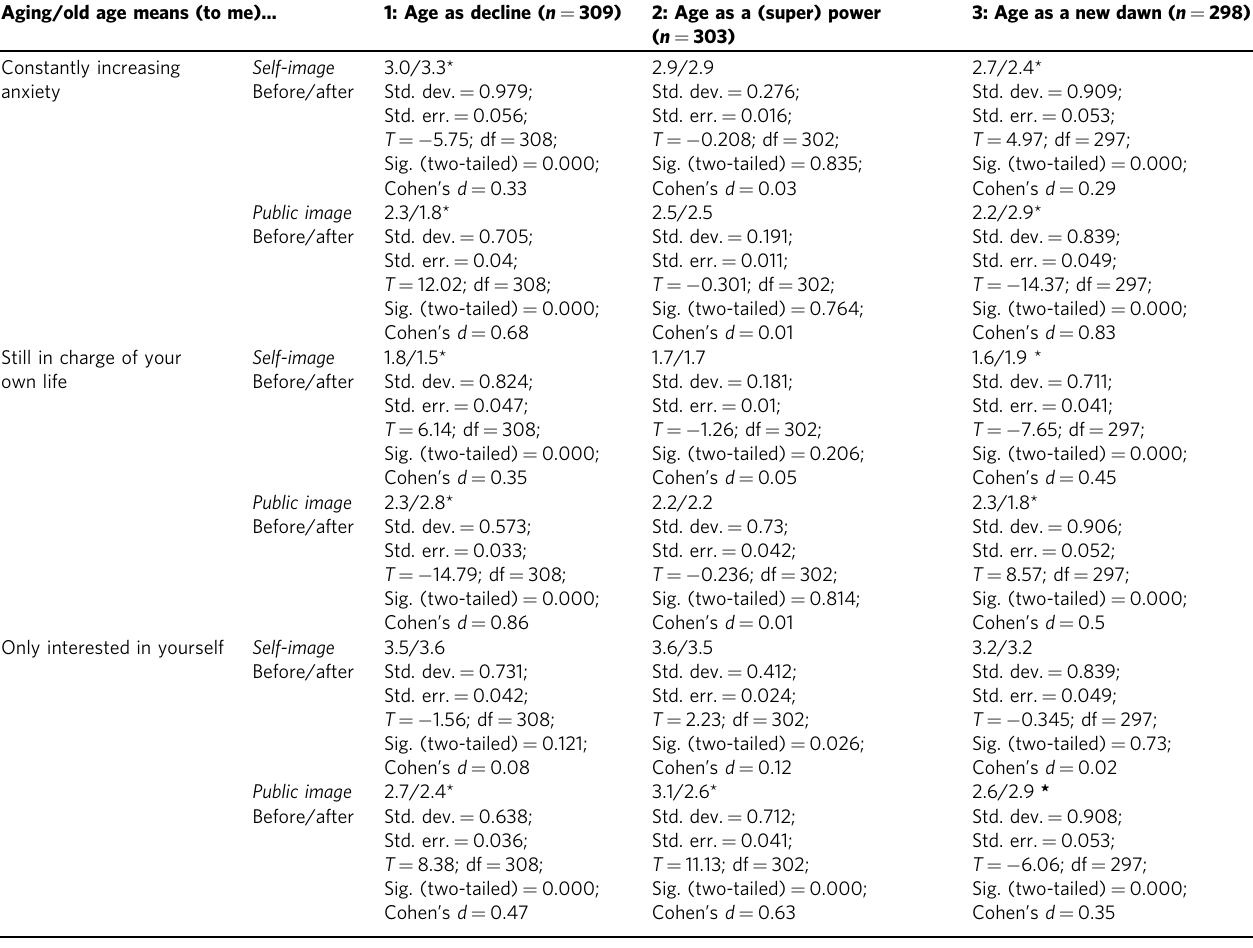
Table 3 Public and self-image of old age with repeated measurements (mean values). Aging/old age means (to me)